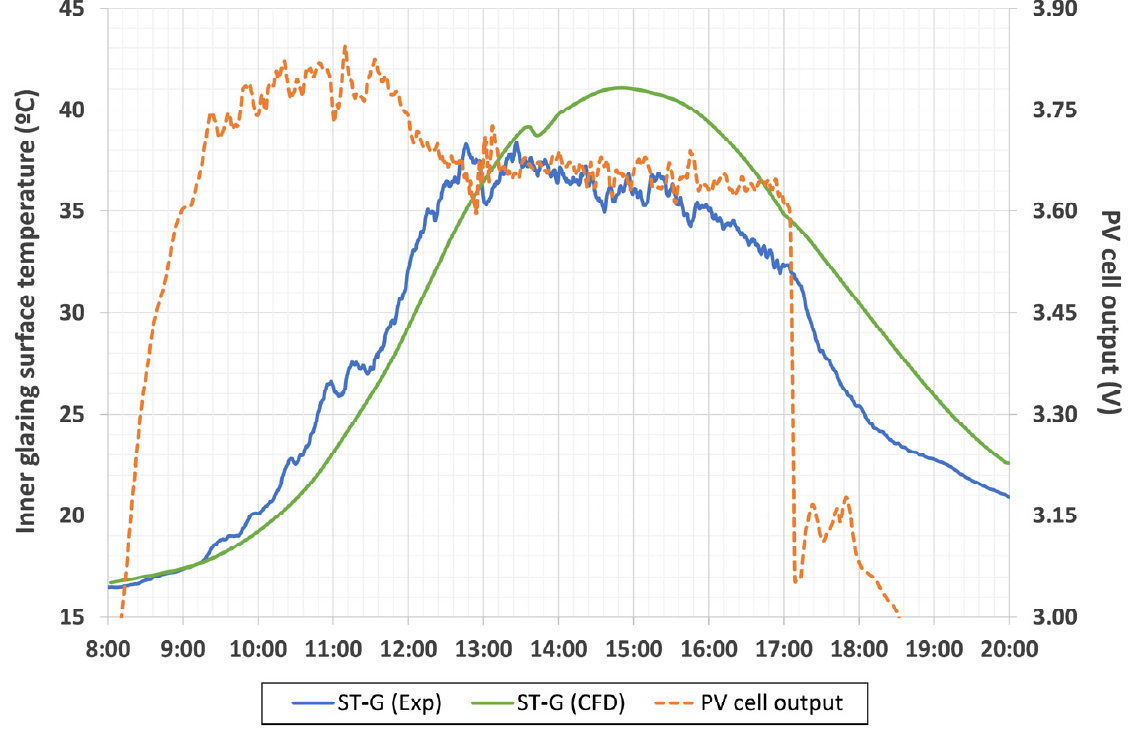
Figure 10. Inner glazing temperature validation.